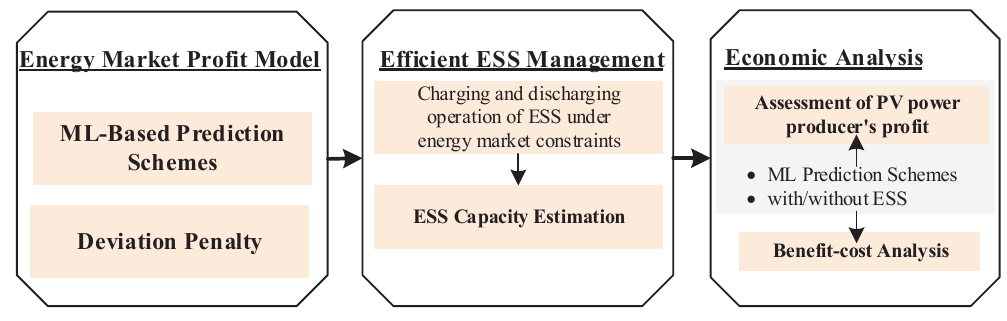
Figure 1. Research workflow of ESS-based PV power